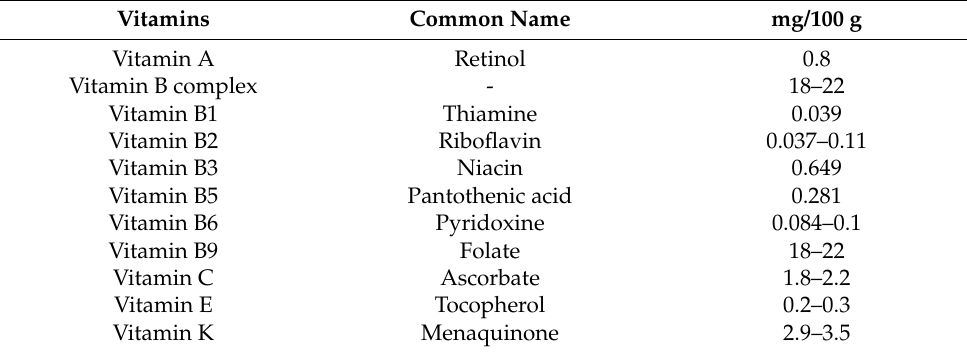
Table 3. Vitamins and their content in eggplant (mg per 100 g) [10].